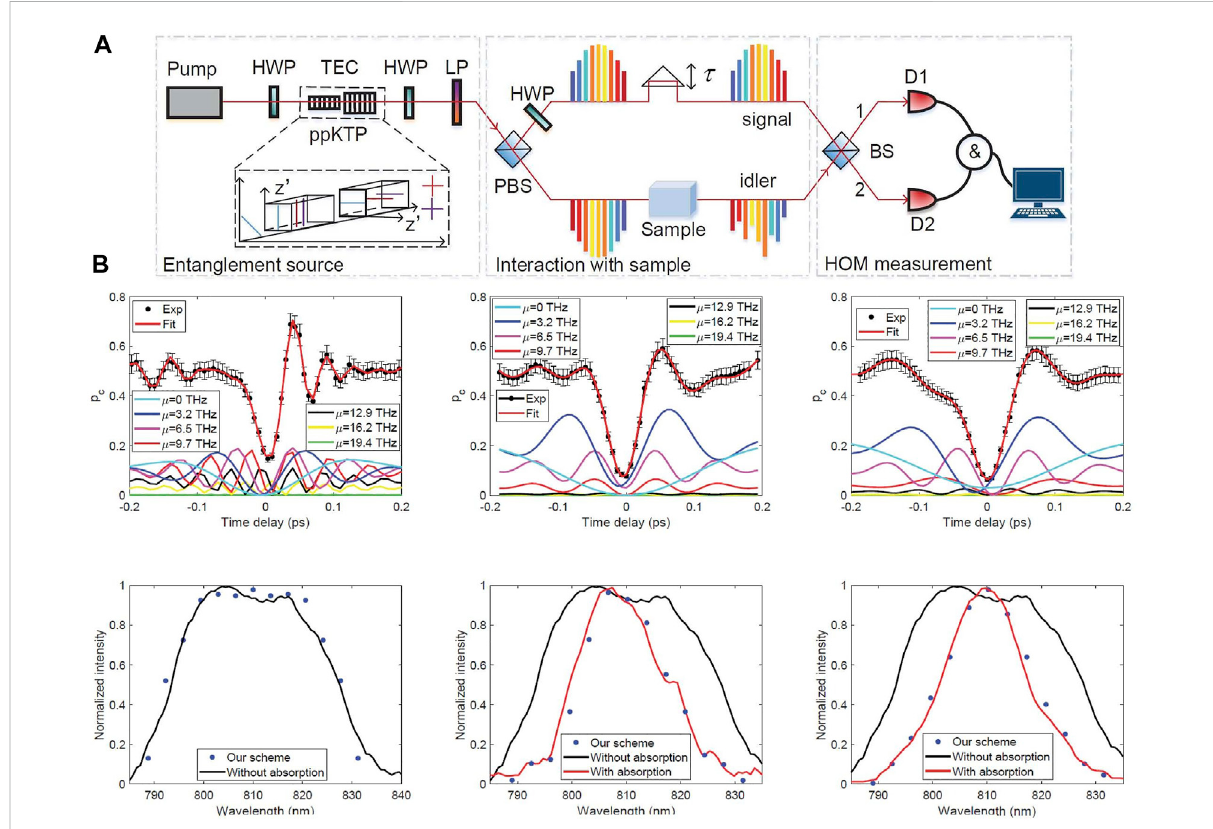
FIGURE 6 (A) Experimentalsetupforentanglement-assisted absorption spectroscopybyusingHOMinterference. (B) Theexperimentalreconstructionof the spectra of two optical microcavities at resonance wavelengths of 806 and 810 nm. The colorful lines represent the interferencepatternsof sub- entanglement with various frequency detunings. Since the whole spectra are sampled by averaging them within each of m = 13 frequency bins, and they satisfy the strict energy conservation as a direct result of the exploitation of the pump with ultranarrow frequency linewidth, the resultant 7 pairs of subentanglement with frequency detunings μ = 0 THz, μ = 3.2 THz , μ = 6.5 THz, μ = 9.7 THz, μ = 12.9 THz, μ = 16.2 THz and μ = 19.4 THz. Reprinted with permission from ref. [125]. Copyright (2022) by the American Physical